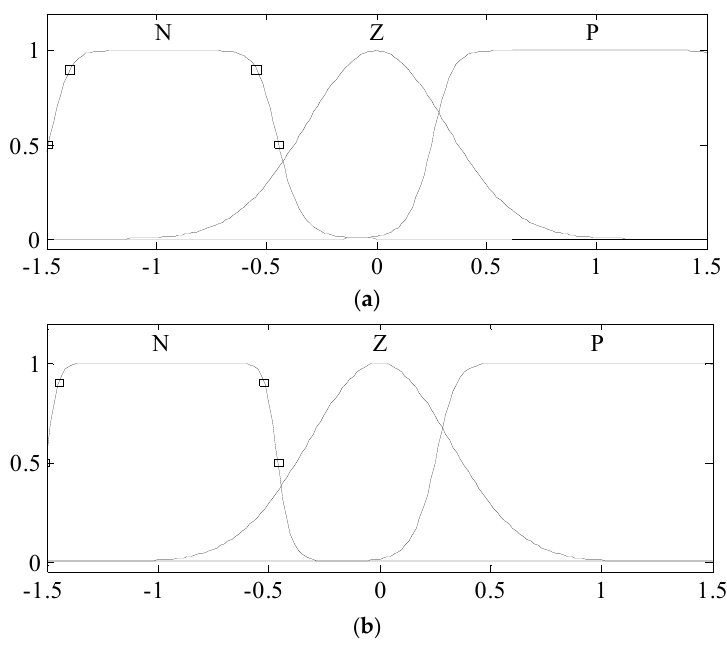
Figure 4. Inputs variables of fuzzy logic controller (FLC): ( a ) “e” and ( b ) “ce”.